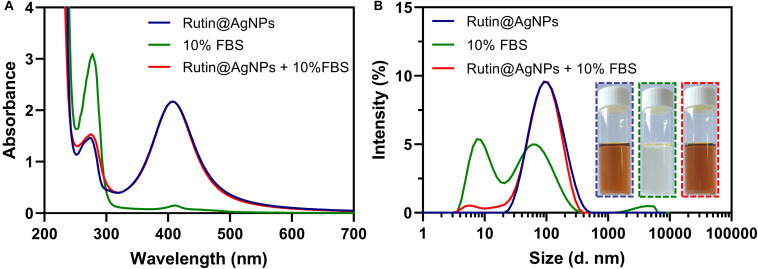
(A) UV-vis spectra, (B) size distributions, and photographs of Rutin@AgNPs cultivated in the solution containing 10% FBS for 3 days.